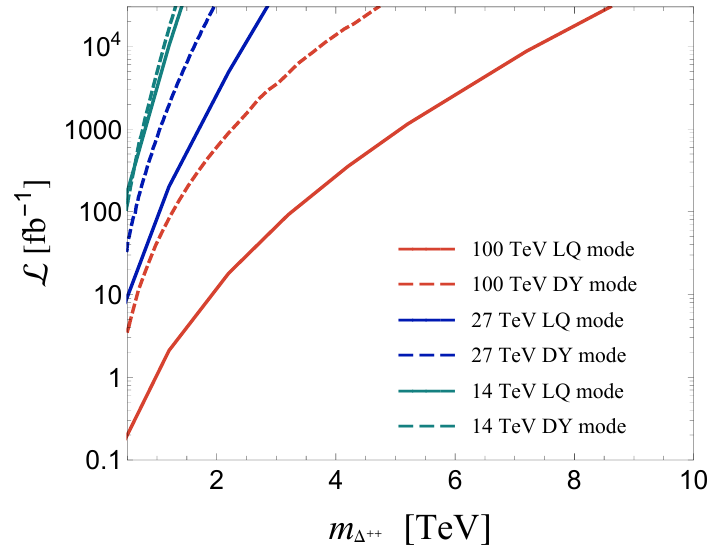
Figure 14 . Required integrated luminosities for different center-of-mass energies of the pp collider to observe at least 25 events for the signal pp → ∆ ++ ∆ −− + X → µ + µ + µ − µ − + X in the LQ and DY production